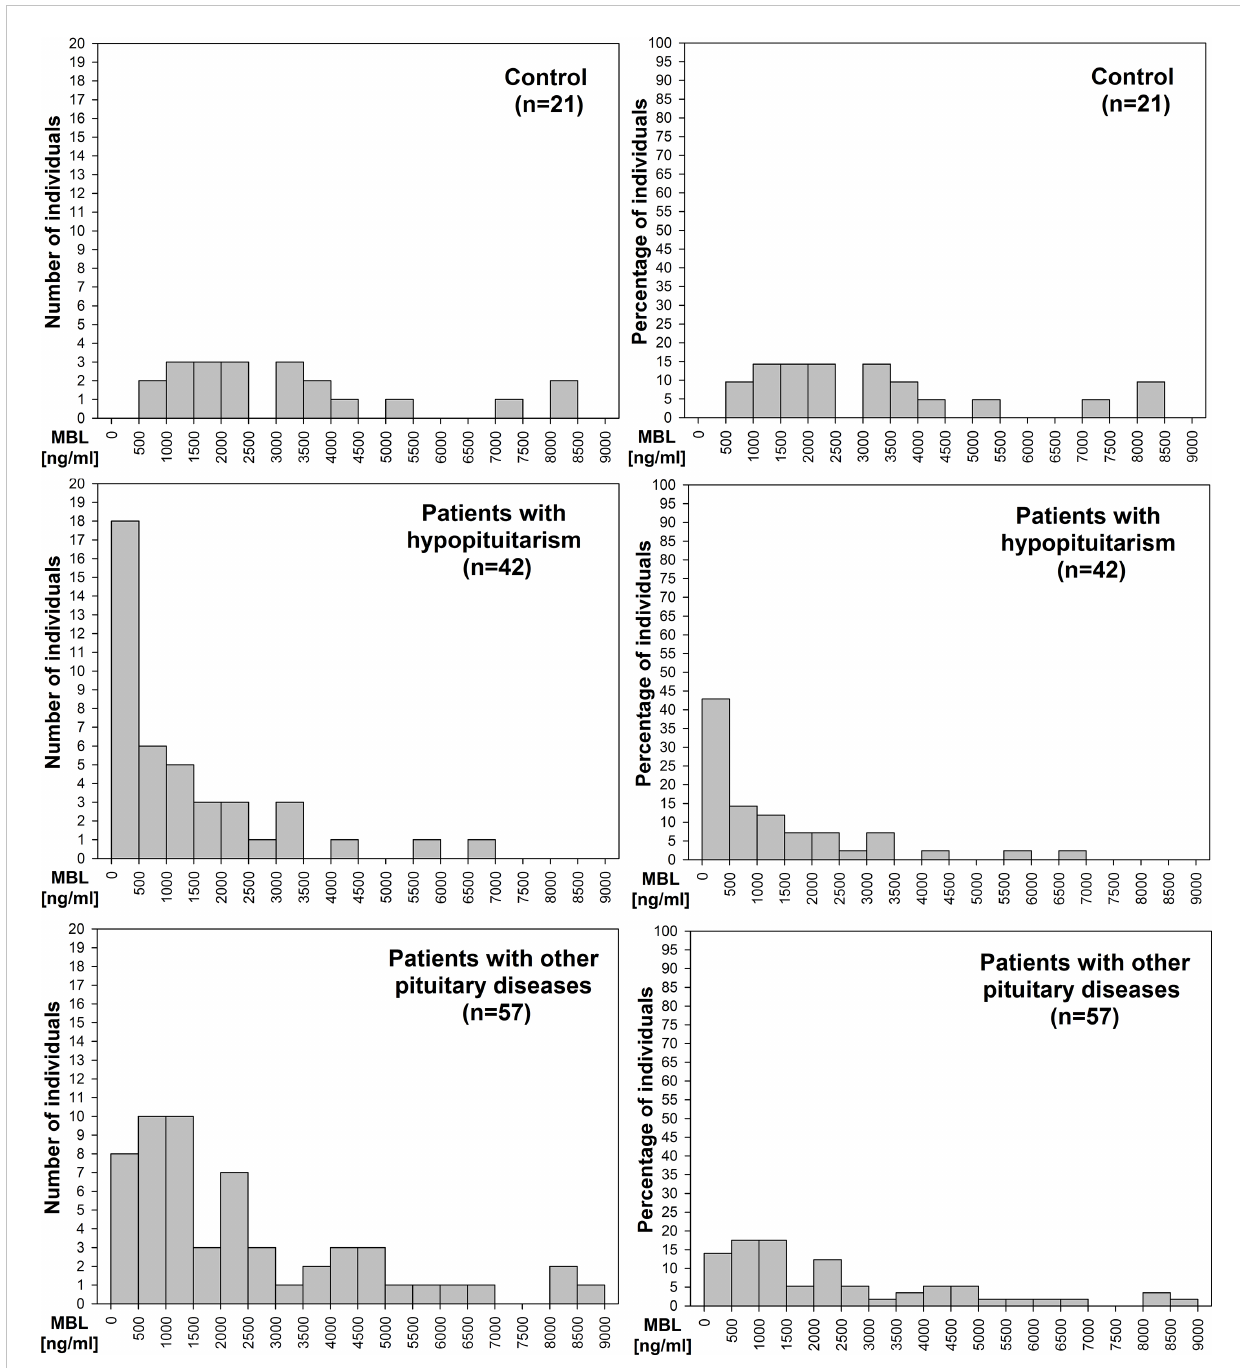
FIGURE 3 Histograms of the distribution of number of patients (left graphs) or percentage of patients (right graphs) with relation to mannan-binding lectin (MBL) level in control individuals (n=21), in patients with hypopituitarism (n=42), and in patients with other pituitary diseases